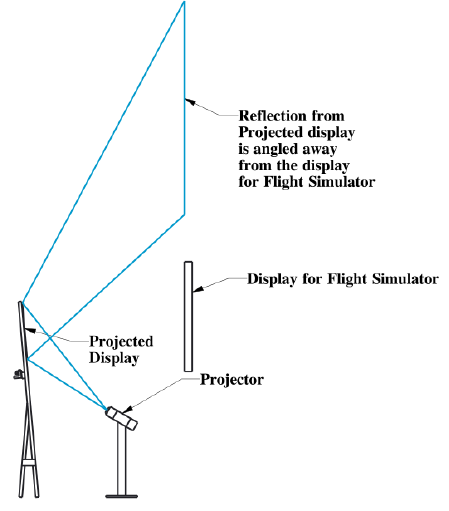
Figure 5. Reflection from projected display.